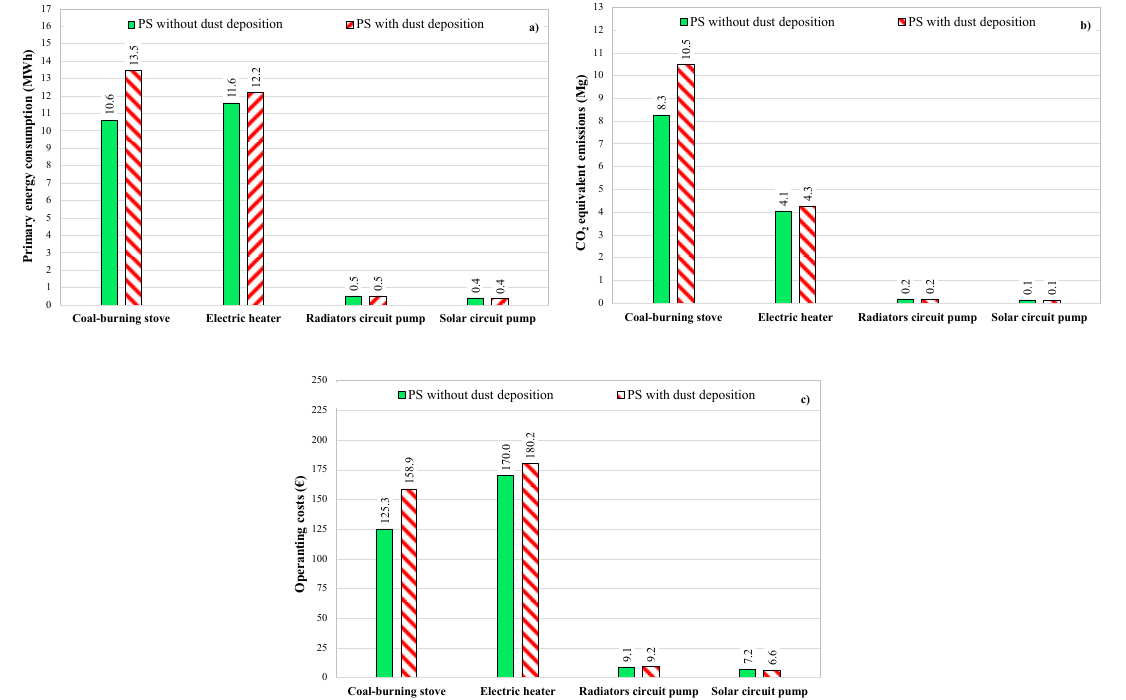
Figure 14. Primary energy consumption ( a ), CO 2 equivalent emissions ( b ) and operating costs ( c ) associated with the components of the proposed system (with and without dust deposition effects) during the heating season.